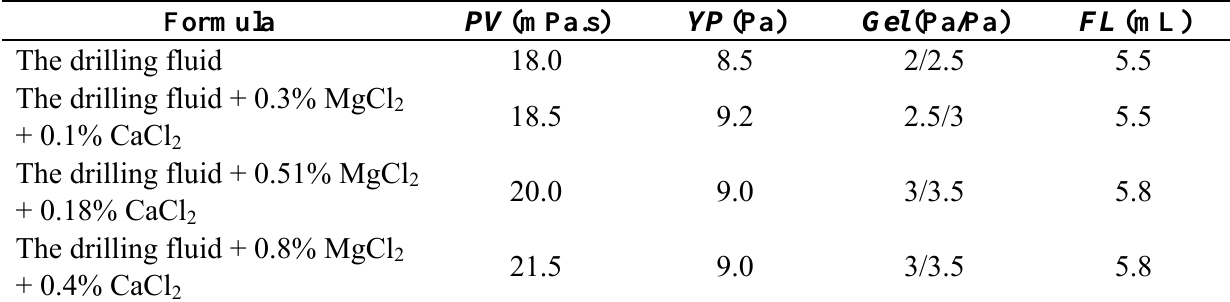
Table 3. Experiment for preventing pollution by calcium and magnesium